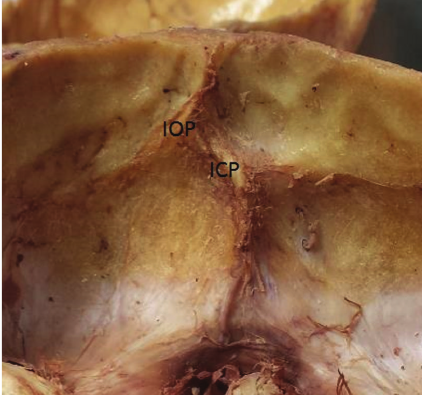
Figure 2: Frontal/superior view of the occipital bone and the misalignment of internal occipital crest (IOC) and internal occipital protuberance (IOP).